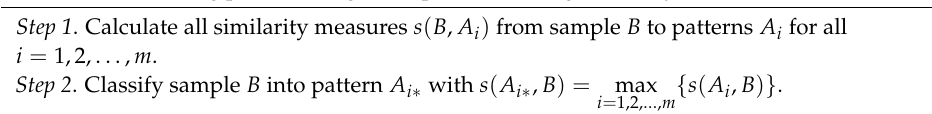
Algorithm 1 Solving pattern recognition problems using similarity